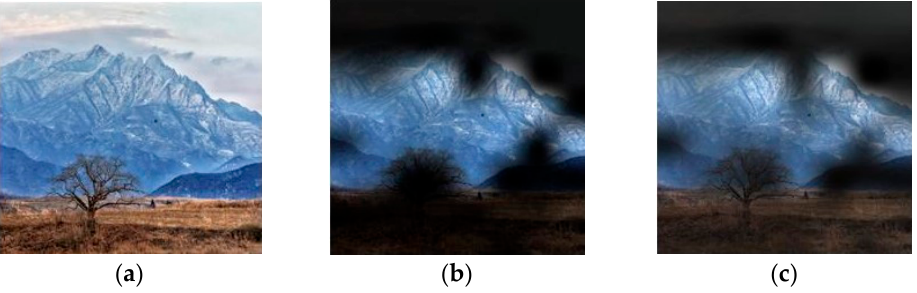
Figure 4. Examples of FFP(x, y) and AIR(x, y). ( a ) Original image; ( b ) FFP(x, y); ( c ) AIR(x, y). It seems that the highlighted regions of (b) and (c) are close to the human’s perception regarding FFP and AIR when enjoying an image.